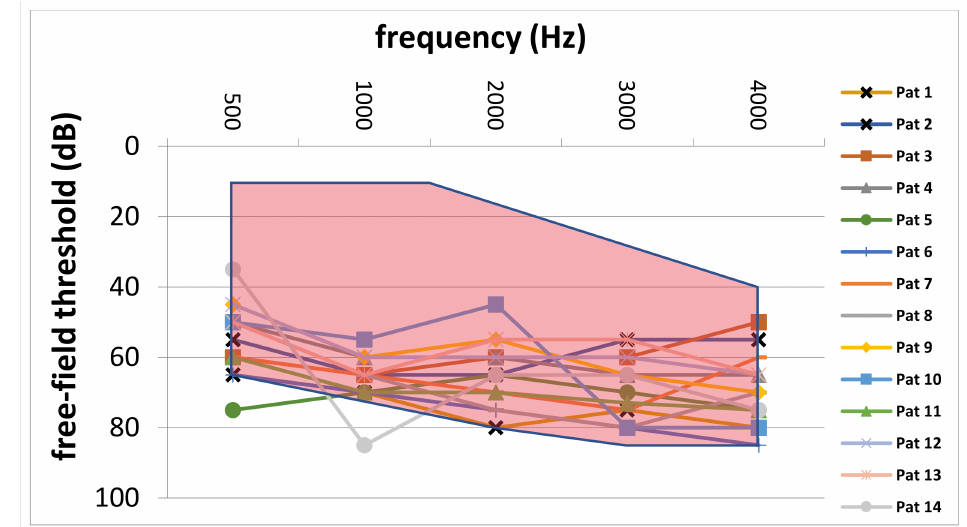
Figure 6. Individual preoperative PTA AC thresholds of patients in the CI group. The red area marks the indication area for AC thresholds (in the shown frequencies and sound levels) for VSB implantation for patients with SNHL. PTA, pure-tone audiometry; AC, air-conduction; CI, cochlear implant; VSB, Vibrant Soundbridge; dB, Decibel; Hz, Hertz; Pat, patient; SNHL, sensorineural hearing